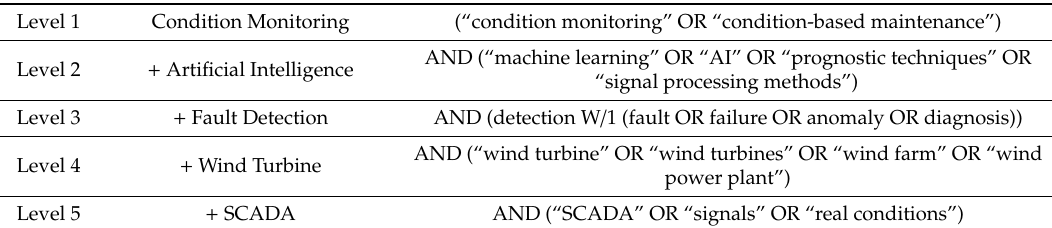
Table 1. Semantic search structure.